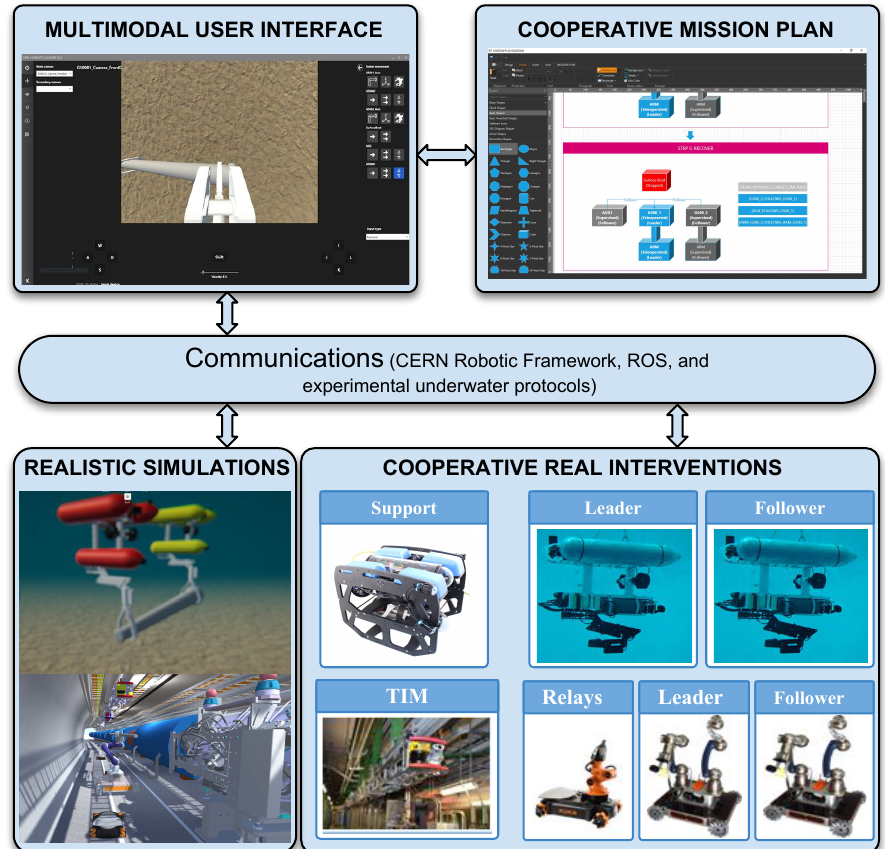
Figure 4. Common technological aspects of cooperative interventions in radioactive and underwater